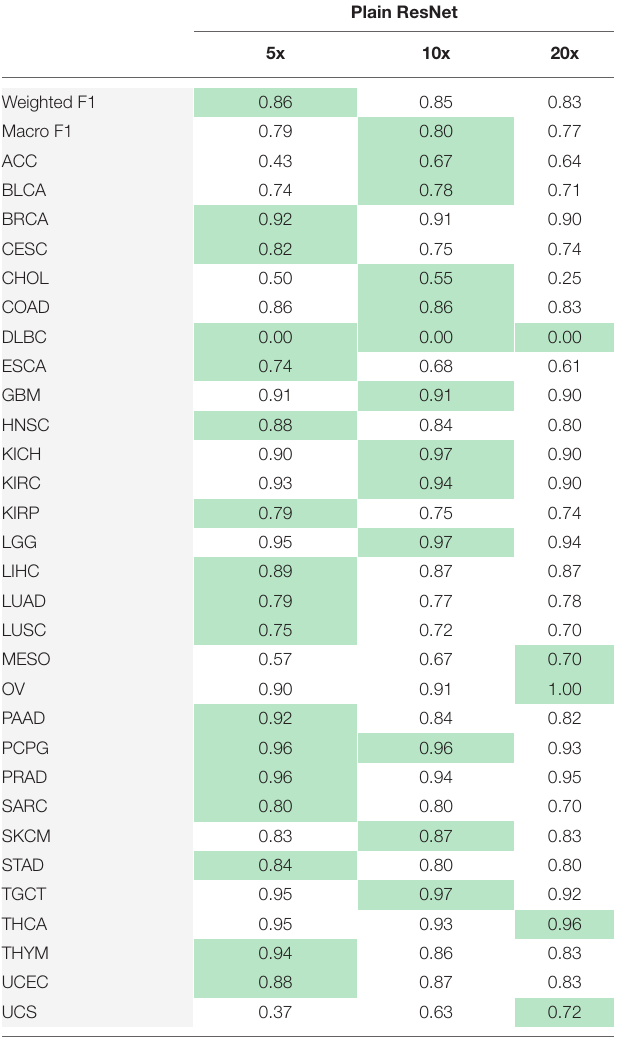
TABLE 1 | Results obtained training the plain ResNet to perform the cancer type